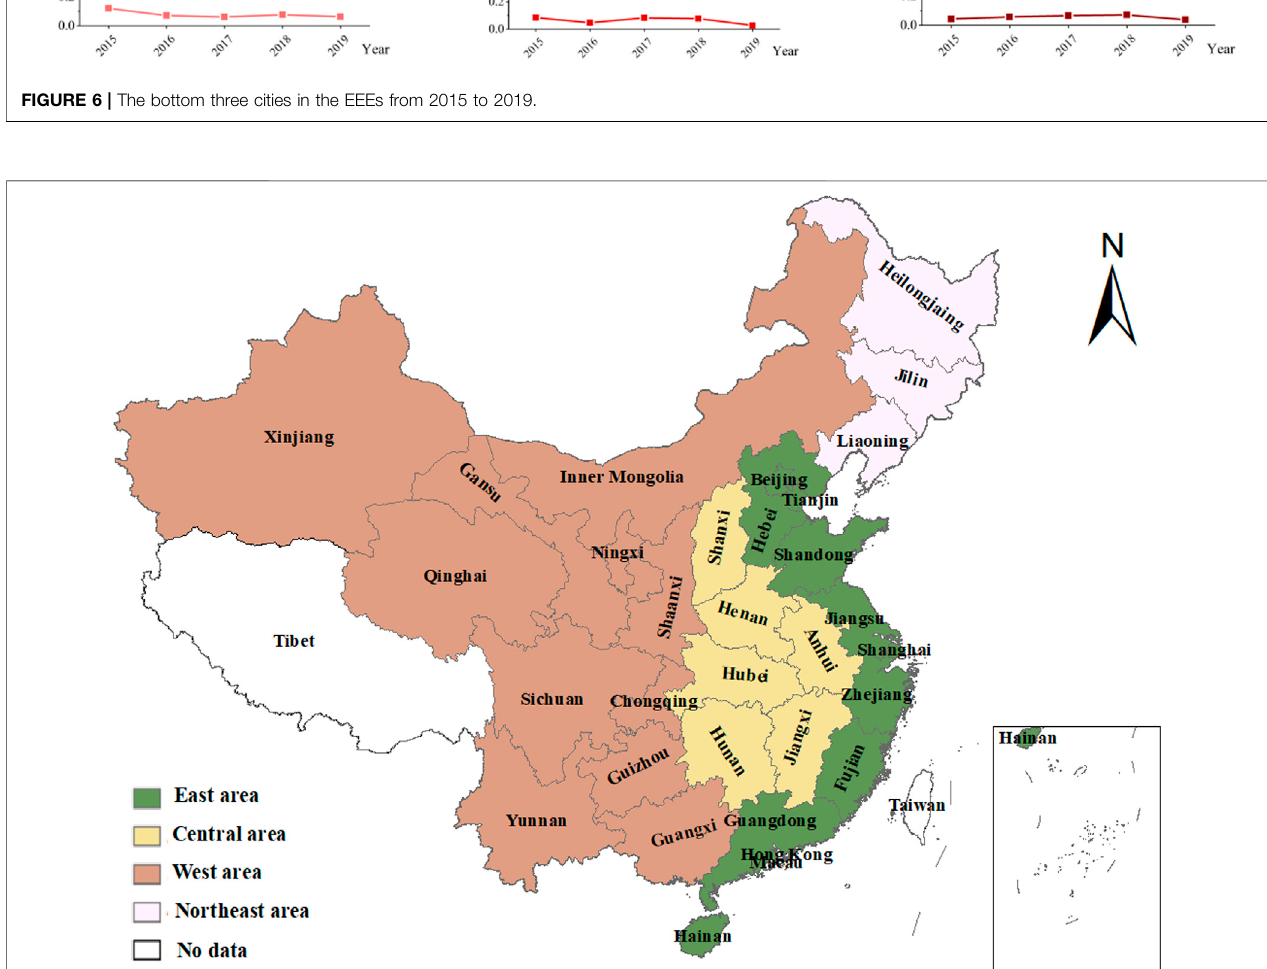
FIGURE 7 | The division of economic zones in mainland